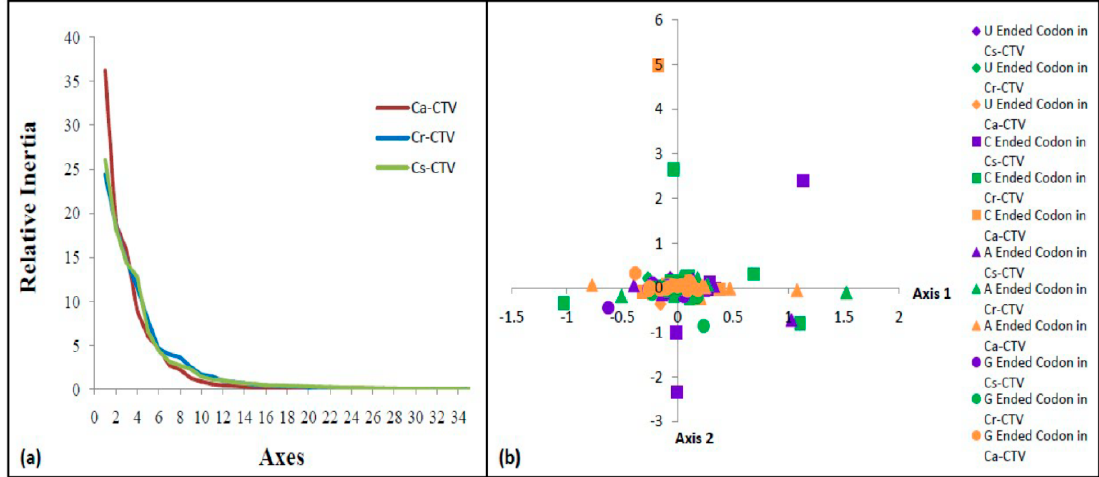
Figure 4. ( a ) Contribution axes based on the correspondence analysis (COA). The relative inertia of 34 axes generated by COA of the relative synonymous codon usage (RSCU) values of CTV subgroup isolates. ( b ) COA analysis of synonymous codon usage patterns: RSCU values of the 59 synonymous codons of three CTV subgroup isolates were plotted in the first two main axes (Axis 1 and Axis 2). Different nucleotide-ended codons of each CTV subgroup isolates are marked in the figure by different colors and shapes.